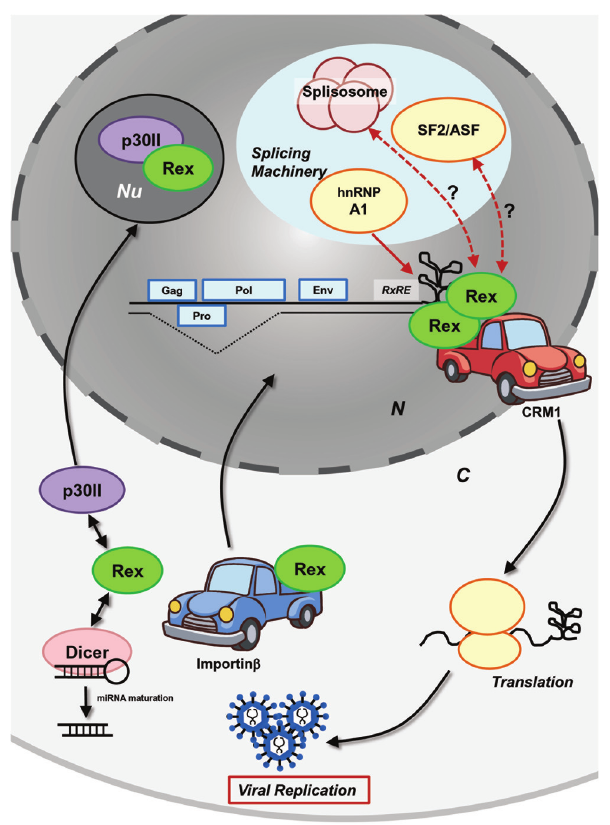
FIGURE 2 | Molecular mechanism of HTLV-1 Rex function. HTLV-1 Rex specifically binds to the RxRE motif of HTLV-1 transcripts. Rex also interacts with the cellular nucleocytoplasmic shuttling protein, CRM1, through its NES. Consequently, the Rex–viral mRNA complex is exported from the nucleus by CRM1. In the cytoplasm, Rex subjects viral transcripts to the cellular translational machinery to enhance viral production. Released Rex binds to importin β via its NLS and returns to the nucleus by the importin complex shuttling activity. P30II binds to Rex through its NLS and retains Rex in the nucleolus for suppression. Rex not only transports viral transcripts, but also inhibits splicing of viral mRNA that encode structural proteins. hnRNP A1, which governs the processing/splicing of pre-mRNA and transport of mature mRNA, was found to bind to RxRE in a competing manner against Rex. Another major splicing factor, SF2/ASF, was found to influence the processing of HTLV-1 mRNA (i.e., overexpression of SF2/ASF resulting in differential pX splice site utilization), although the direct physiological interaction to the viral proteins has not been examined. Recently, Rex was shown to directly interact with Dicer and inhibit its processing of shRNA to siRNA (Abe etal., 2010). Overall, interactions between Rex and other cellular mRNA processing proteins may lead to an unknown molecular mechanism of Rex in the inhibition of the splicing machinery. N, nucleus; C, cytoplasm; Nu,